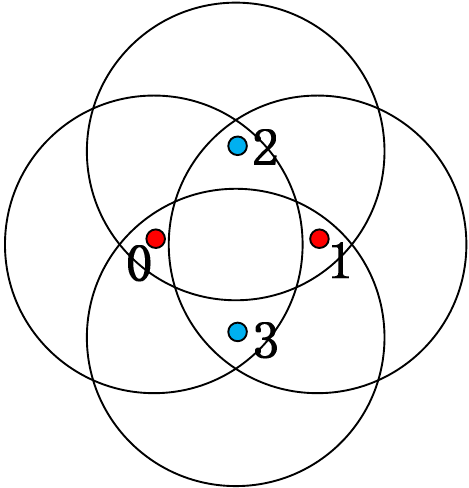
Figure 6. Example of communication lock. For the mini network consisting of 4 nodes, if Node 0 and Node 1 occupy the same slots while Node 2 and Node 3 occupy the same slots, they are trapped in a communication lock. Nodes that occupy the same slots are marked with the same